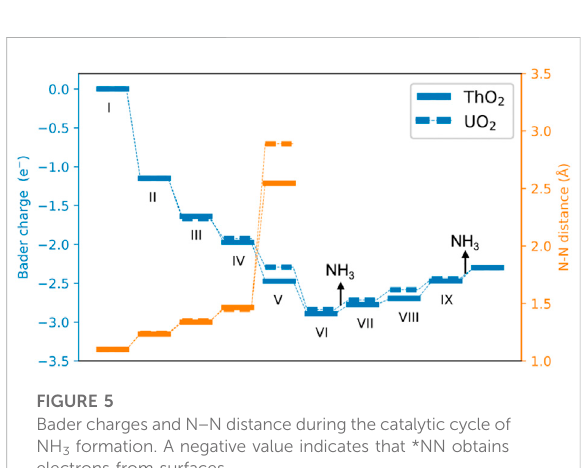
Bader charges and N − N distance during the catalytic cycle of NH 3 formation. A negative value indicates that *NN obtains electrons from